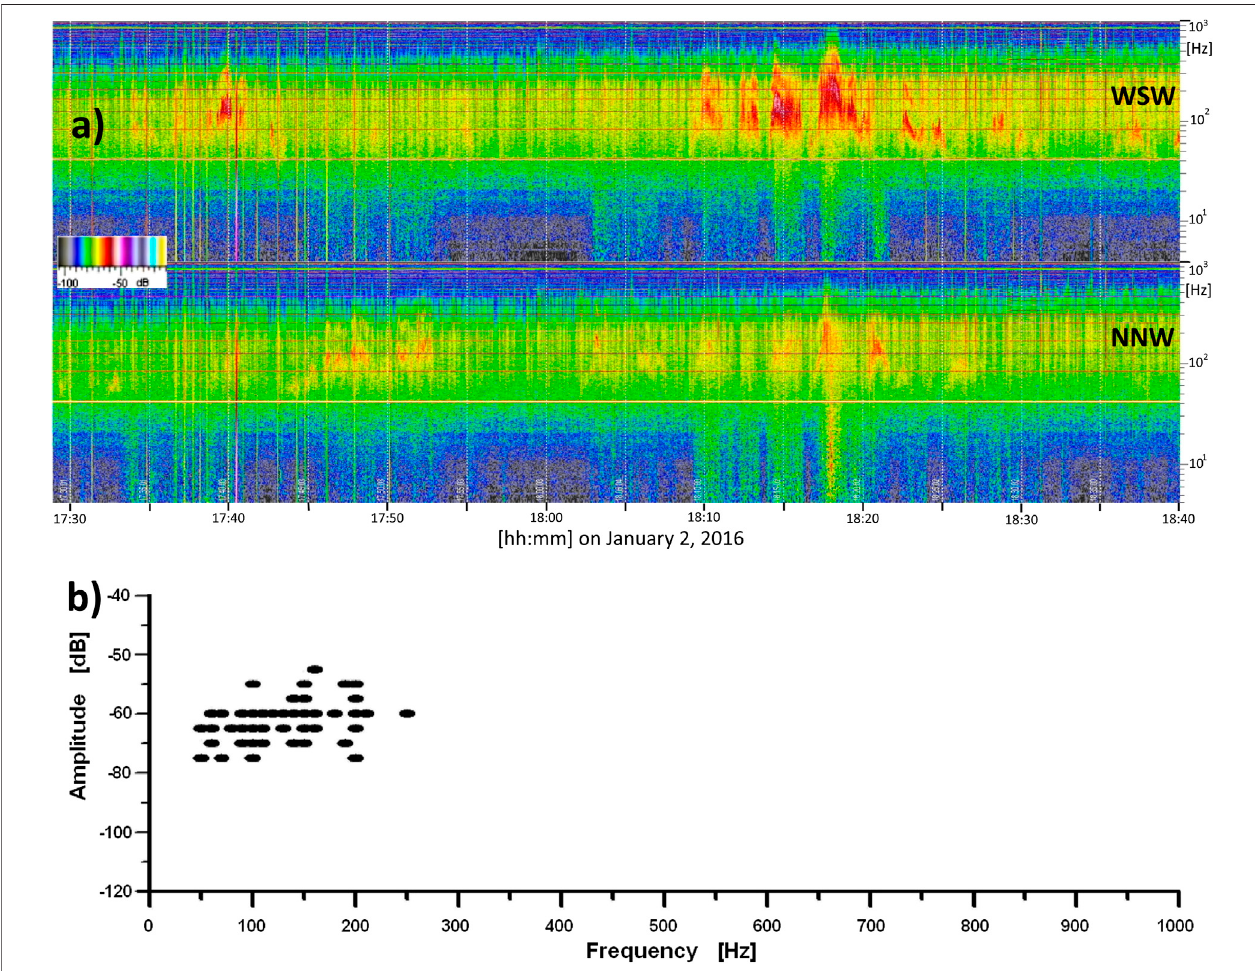
FIGURE3|A) DynamicspectraofbothWSWandNNWelectrodesrecordedonJanuary2,2016duringtheafternoon.Recordingslasted70 minandshowseveral electric phenomena of natural and anthropological origin. The evident vertical lines covering the entire frequency band and characterized by high intensity are EM waves produced by lightning bolts not too far from the station (Barr et al., 2000). The green band represents the numerous lightning strikes that occurred at distances of thousands of kilometres in the tropics. Red spots are the electrical oscillations. (B) A typical spectrum of maximum daily electric oscillations recorded at IC1 during several months by Spectrum Lab software before the main strike of Norcia. It consists of 81 events of electric oscillations, which are mainly above the noise threshold of – 80 dB; all of them fall between 50 and 250 Hz.